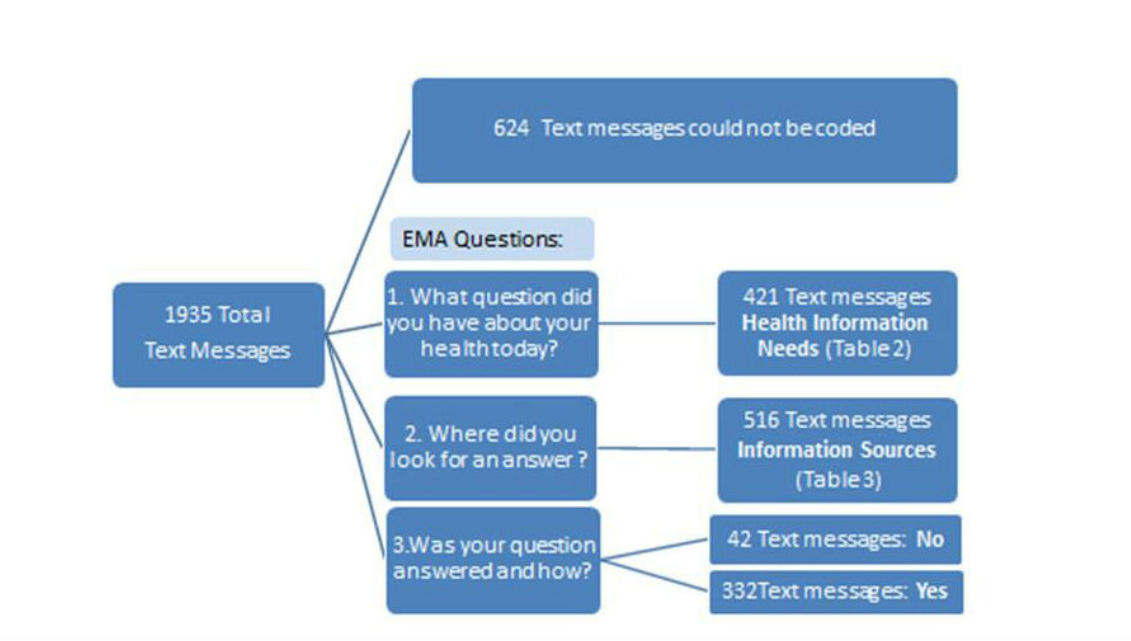
Figure 2. Flowchart of text message